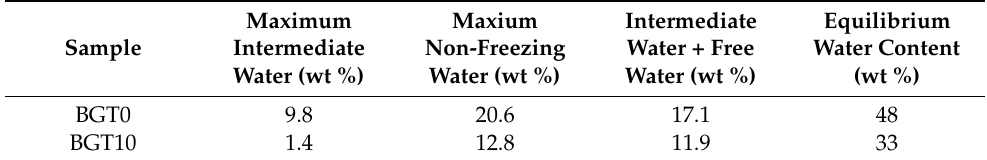
Table 2. Hydration structure analysis of BGT0 and BGT10 samples determined by differential scanning calorimetry